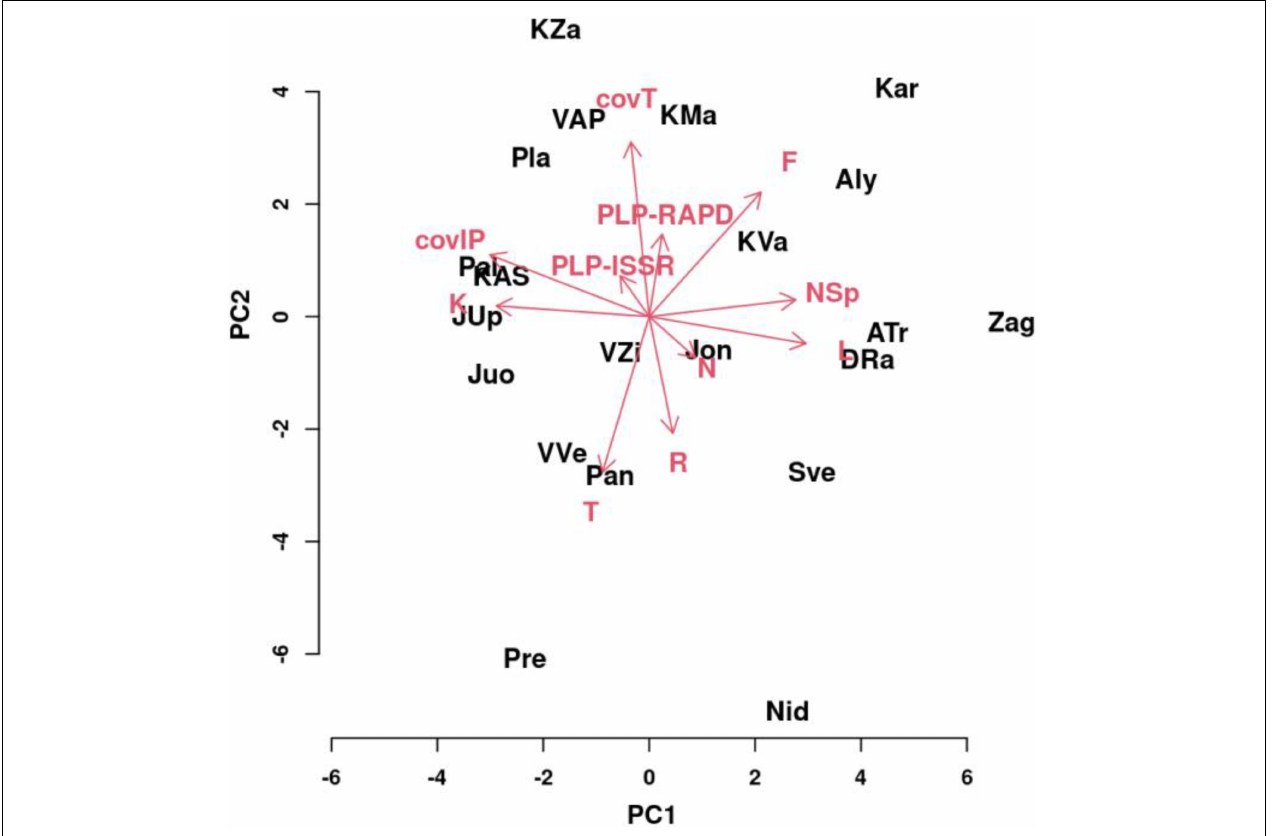
FIGURE 12 | Biplot of the principal component analysis for the first two principal components of a model testing variation of populations depending on molecular markers (PLP at ISSR and RAPD loci), coverage of Impatiens parviflora , total coverage of herbaceous plant species, the number of herbaceous plant species, and abiotic environment features such as W-EIVs’ (L, light; T, temperature; K, continentality; F, moisture; R, pH; N, nutrients). Three black letters denote populations and red arrows with letters denote